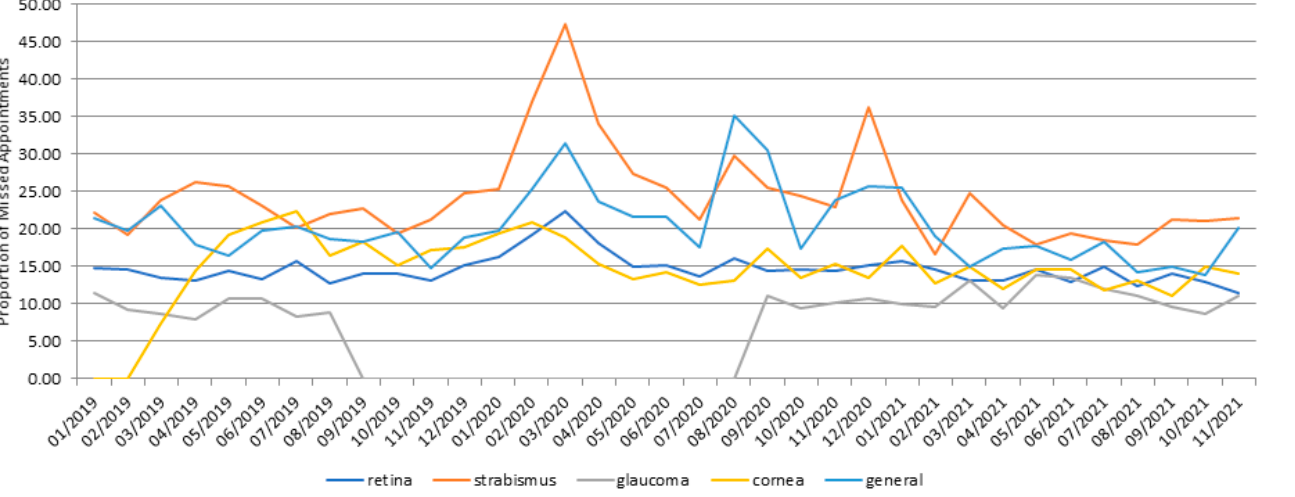
Table 2. Differences in age, gender, residence, and other patient factors by period (pre-COVID-19, early COVID-19, and late COVID-19).